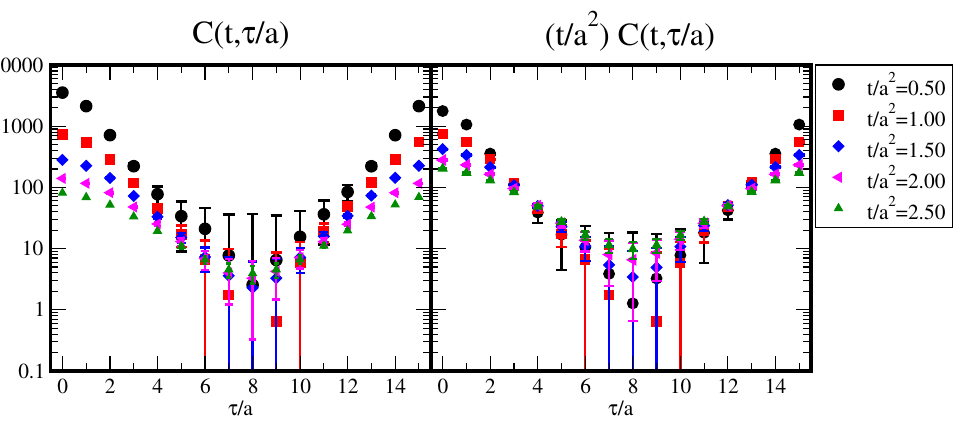
Figure 3 . The correlation function of T R